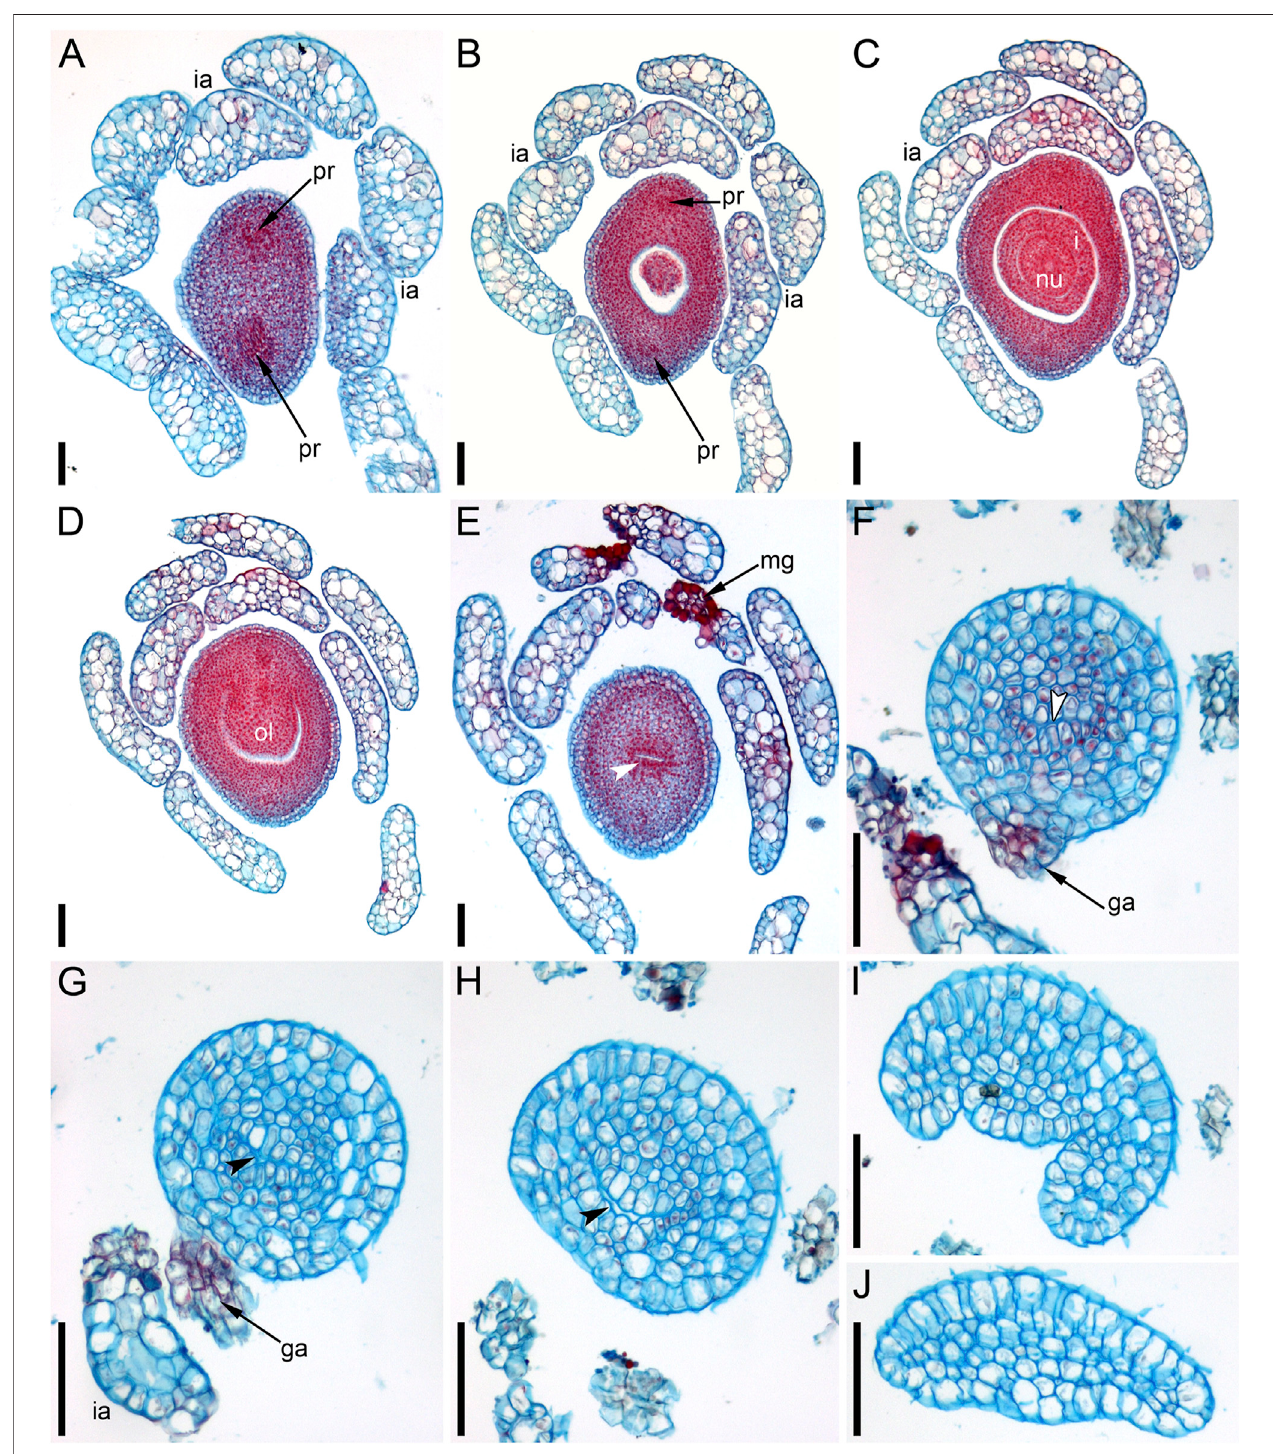
FIGURE 5 | Ascending series of anatomical sections of pistillate fl ower of Ceratophyllum demersum with single, abaxial glandular gynoecial appendage (LM). The fl owerissimilartotheoneillustratedin Figure4A . (A) Belowtheovarylocule,notetwovascularbundles. (B) Closetothebottomoftheovule. (C) Middlepartoftheovule. (D) Level of the ovule attachment. (E – H) Sections between the ovary locule and the gynoecial ori fi ce (arrowheads, stylar canal). (F,G) Sections showing the glandular appendage. (I,J) Distal gynoecial outgrowth. Scale bars = 100 μ m in (A – J) .